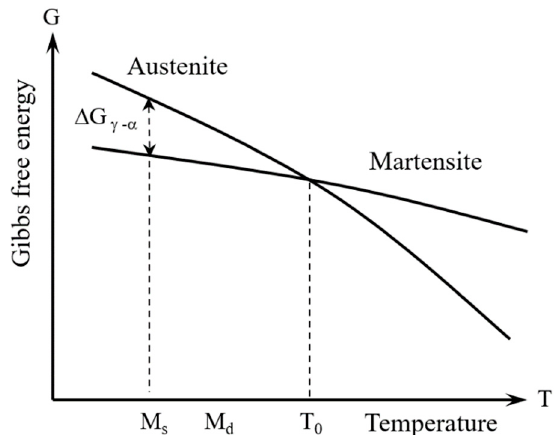
10 of 14 Figure 10. Comparison results of surface microhardness. 3.4. Formation Mechanism of Martensite Transformation During the erosion wear process, the phase transformation of the austenite to the martensite can be explained by phase transformation driving force [31,32]. Figure 11 is a diagram of the relationship between Gibbs free energy and the temperature of austenite and martensite. In the process of martensite transformation, the austenite is the parent phase and the martensite is the new phase. It can be seen that the Gibbs free energy of martensite and austenite are equal at the critical temperature T 0 in Figure 11. It is impossible for martensite transformation to occur when the temperature is higher than T 0 . Above the T 0 temperature, austenite is in a stable region, it is due to the phase transformation from high Gibbs free energy to low free energy. Martensite transformation begins at a certain temperature, which is lower than T 0 , expressed as M s [33]. M s is the martensite transformation temperature, and the difference of Gibbs free energy Δ G α - γ , which is the phase transformation driving force between the parent phase and the new phase. When the temperature is between M s and T 0 , the difference of Gibbs free energy between the two phases is small, and the accumulated energy is not enough for phase transformation. During the erosion wear process, the collision of particles produces heat energy, thus the temperature inside the container increases gradually and the surface